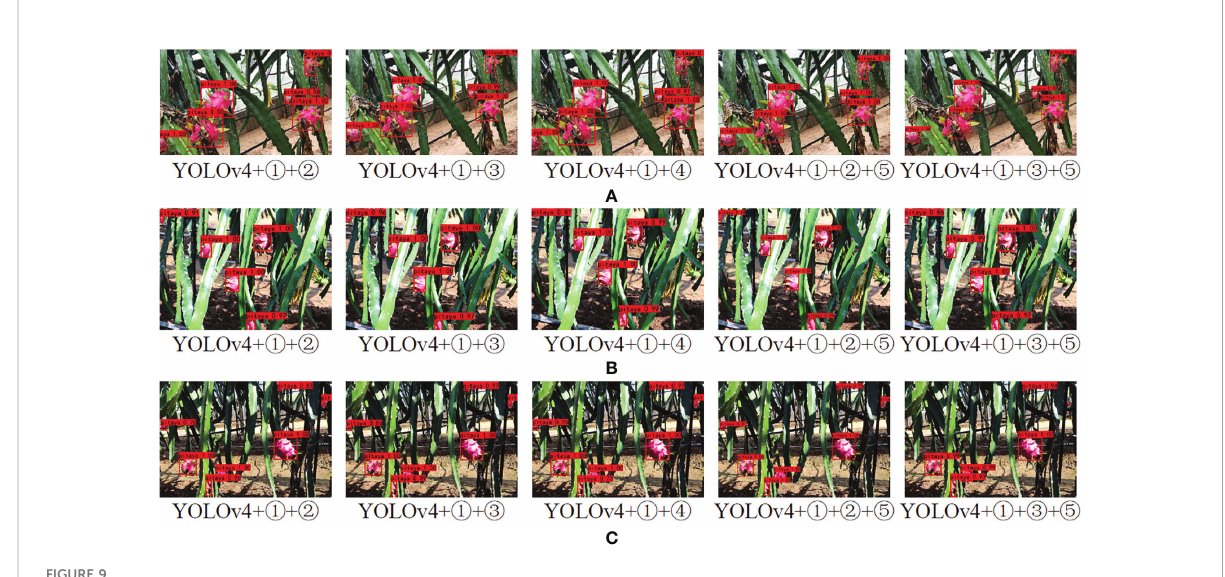
FIGURE 9 Different recognition algorithms for pitayas in three scenes: (A) Rainy weather; (B) Occlusion; (C) TABLE 2 Comparison results of detection performance of different improved networks. Algorithms